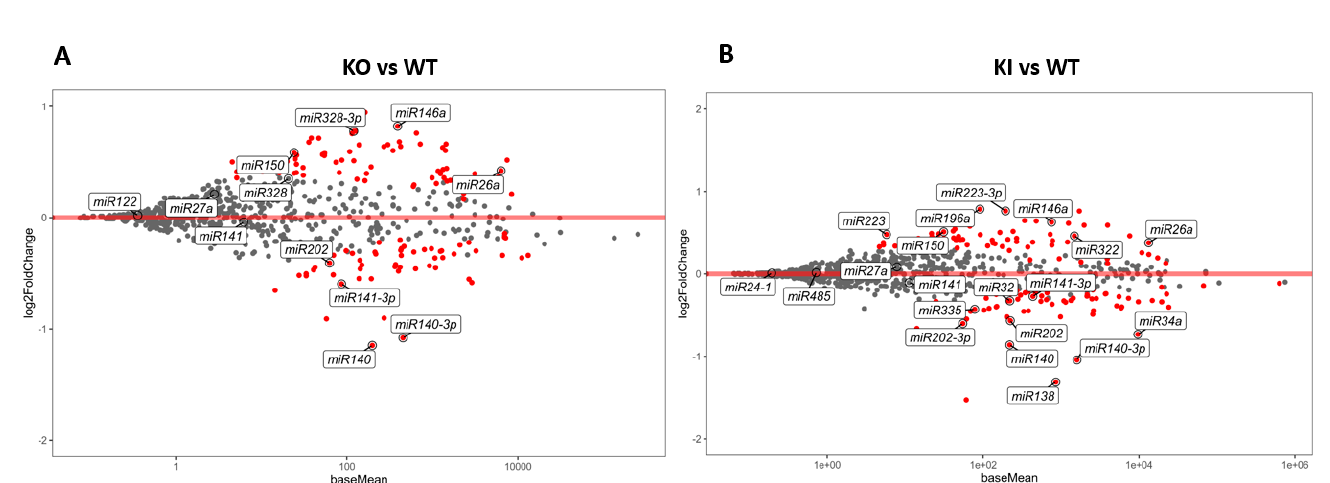
Figure 4. miRNA differential expression in RS from KO, KI, and WT mice. ( A ) MA plot (log2 fold change vs average of counts) shows differentially enriched miRNAs from KO and WT group ( B ) MA plot (log2 fold change vs average of counts) shows DEGs from KI and WT group. The red dots indicate the significantly ( p < 0.1) upregulated or downregulated miRNAs in each of RS of KO or KI compared to WT.